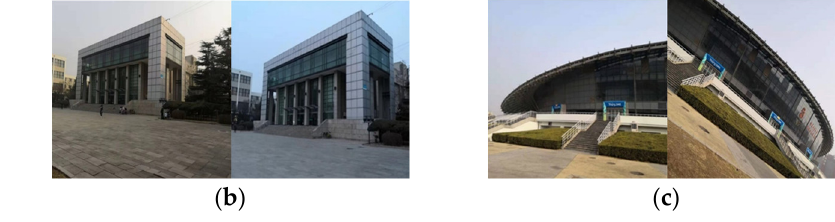
Figure 8. Images to be registered: ( a ) images of the scaling group; ( b ) images of the exposure group; ( c ) images of the rotation group.